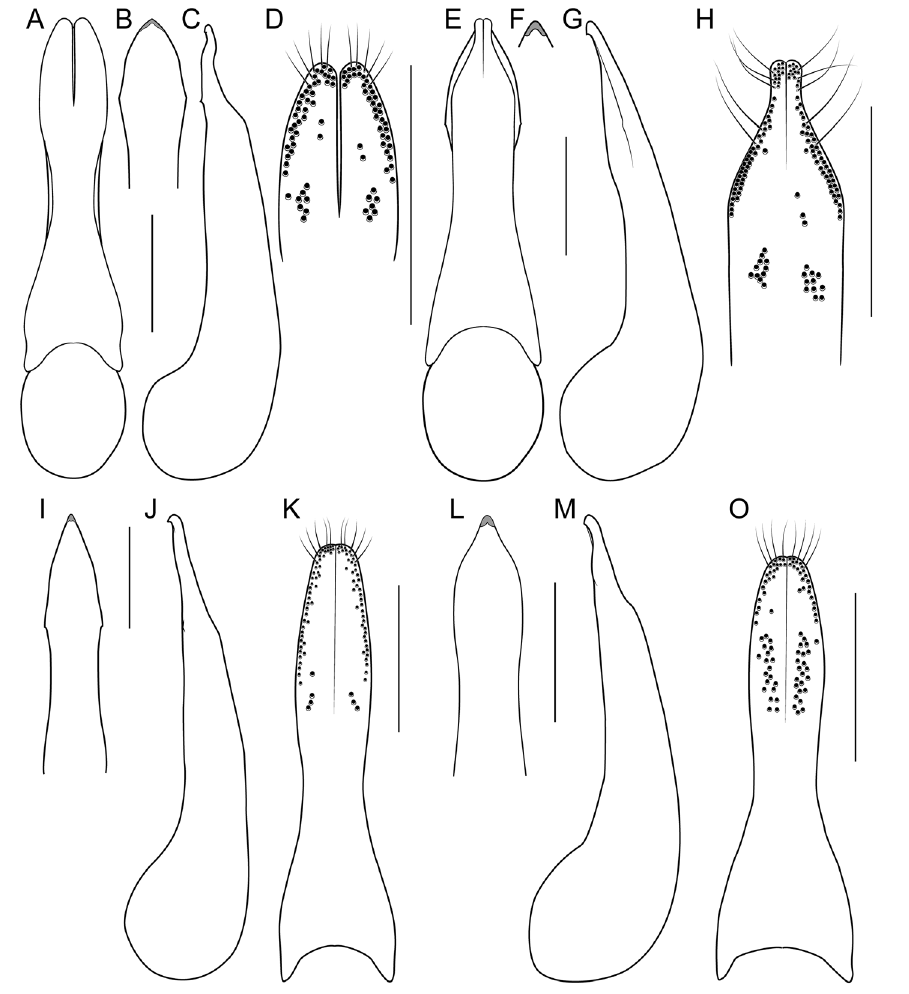
Figure 16. Bolitogyrus hainanensis Cai et al. ( A–D ), B. loculus Cai et al. ( E–H ), B. solodovnikovi Brunke ( I–K ) and B. feai Brunke ( L–O ). Aedeagus in parameral view ( A, E ), apex of median lobe in parameral view ( B, F, I, L ), median lobe in lateral view ( C, G, J, M ), peg setae of paramere ( D, H, K, O ). Figures 16A, B, D, E, F, H modified from Cai et al. (2015). Scale bars: 0.5